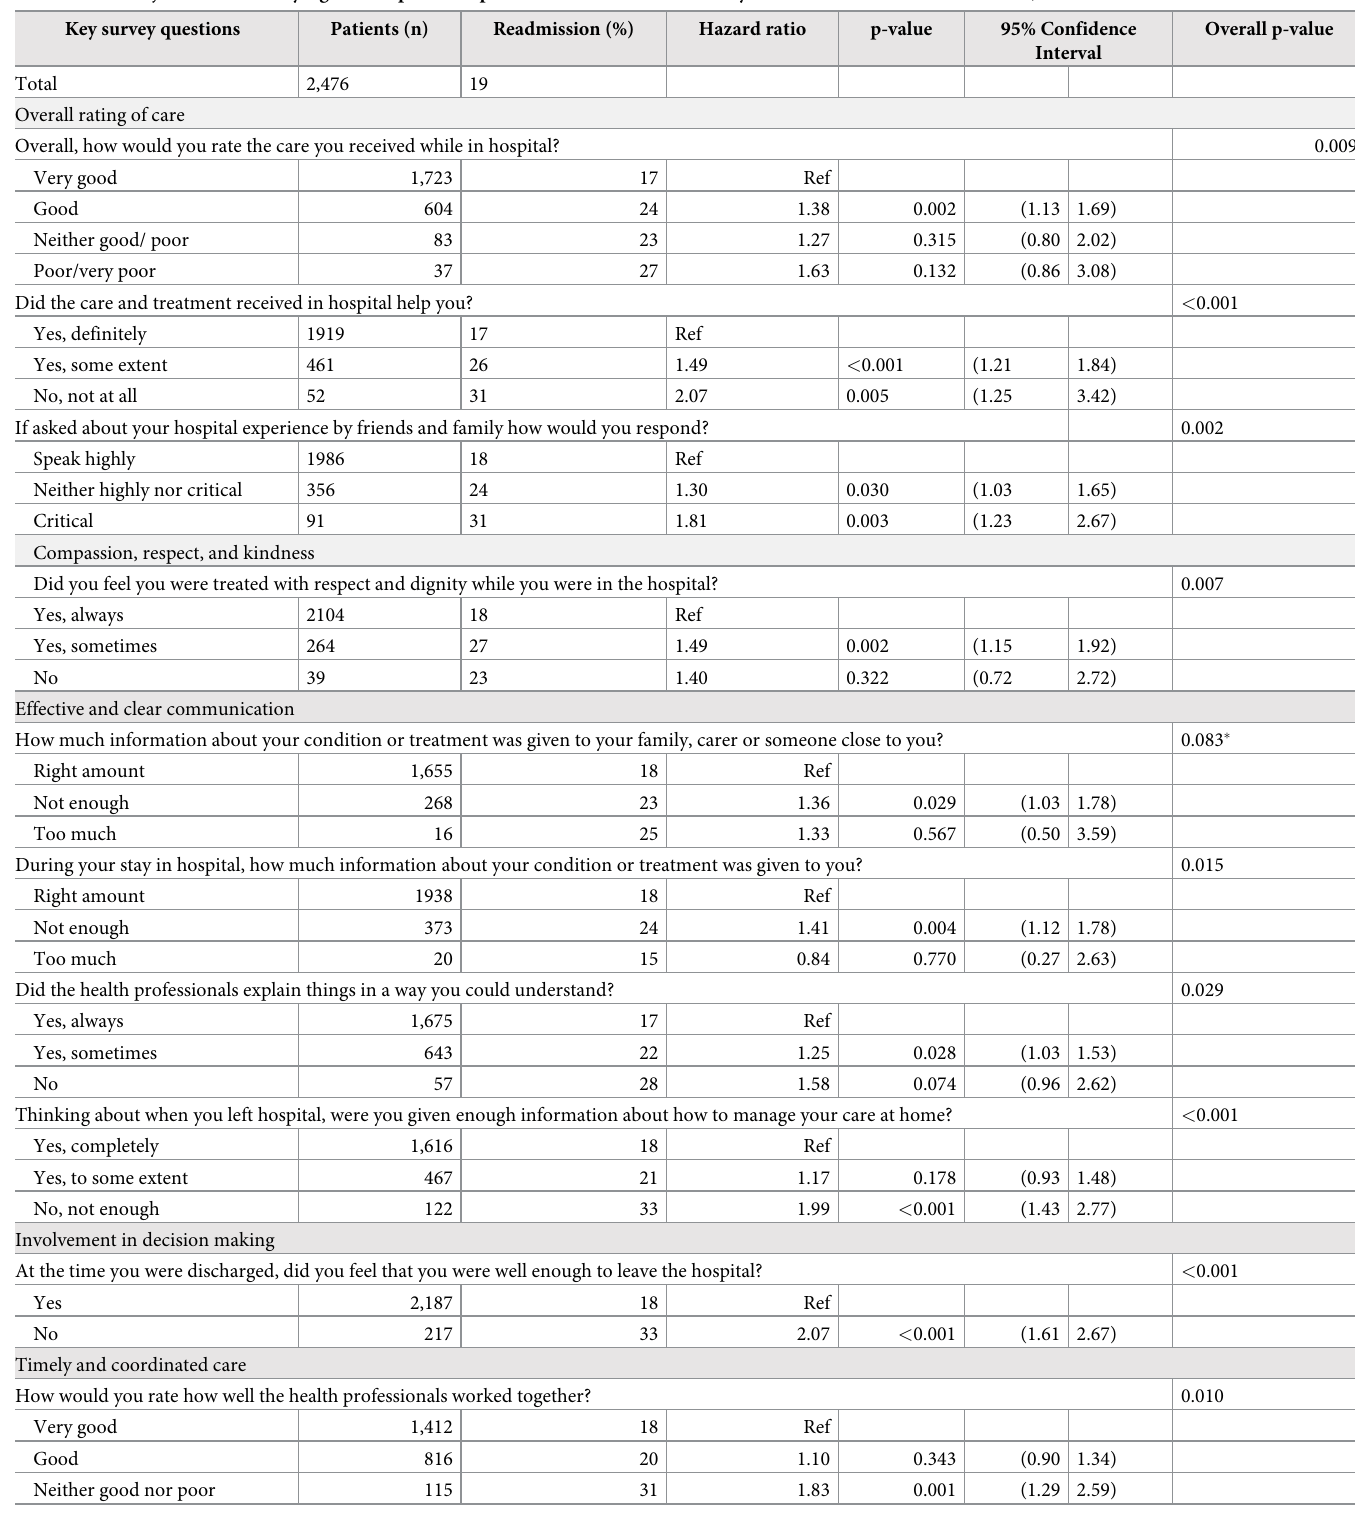
Table 4. Risk-adjusted statistically significant patient experiences associated with 90-day readmissions for adults with CHF, 2018–2020. Key survey